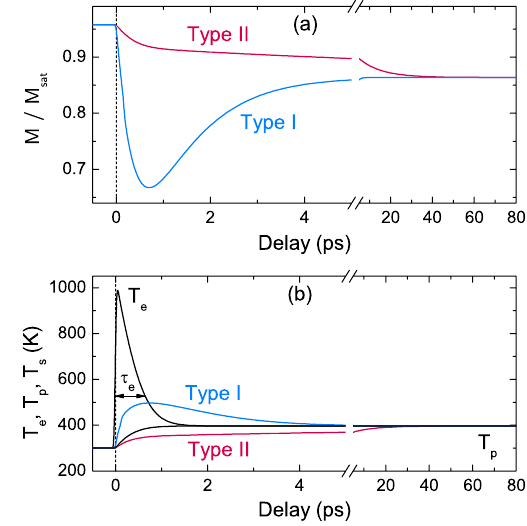
FIG. 1. (a) Examples of Type-I and Type-II magnetization dynamics after excitation by a laser pulse. The magnetization (relative to its value at zero temperature, M sat ) is plotted as a function of delay time between the pump and probe beams. (b) Temperatures of the electron, phonon, and spin systems ( T e , T p , and T s , respectively), as a function of time. For the spin system, both Type-I and Type-II traces are